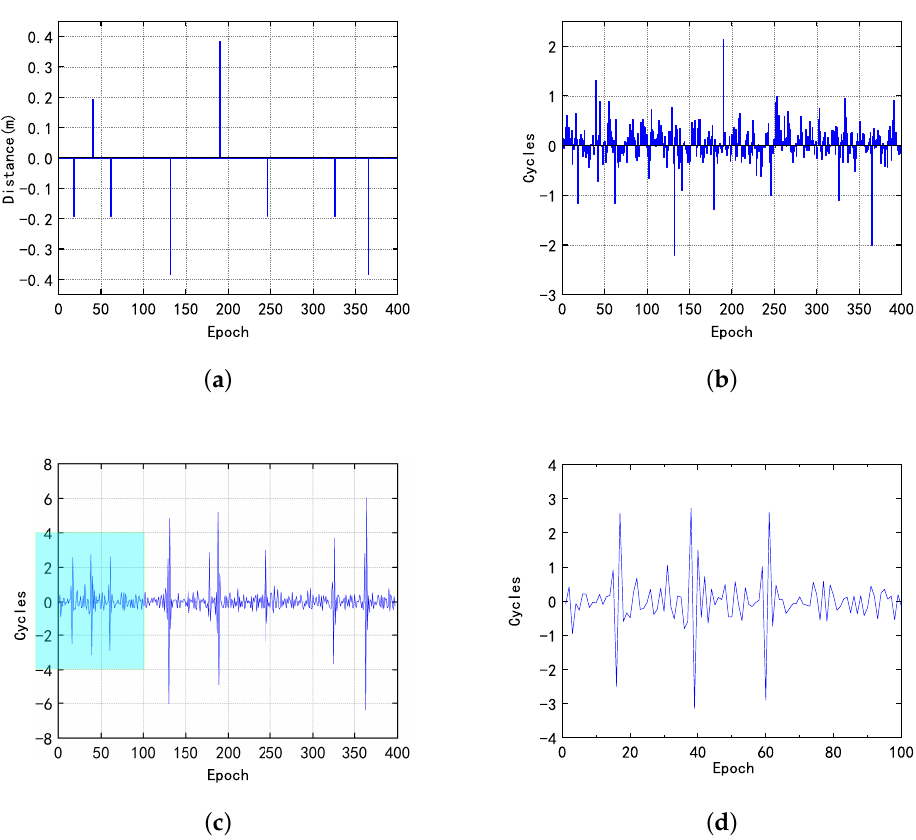
Figure 10. The first case, ( a ) the results obtained by the proposed indoor dual-frequency cycle slip detection method; ( b ) Doppler method; ( c ) high-order difference method; and ( d ) its details of enlarged local value.